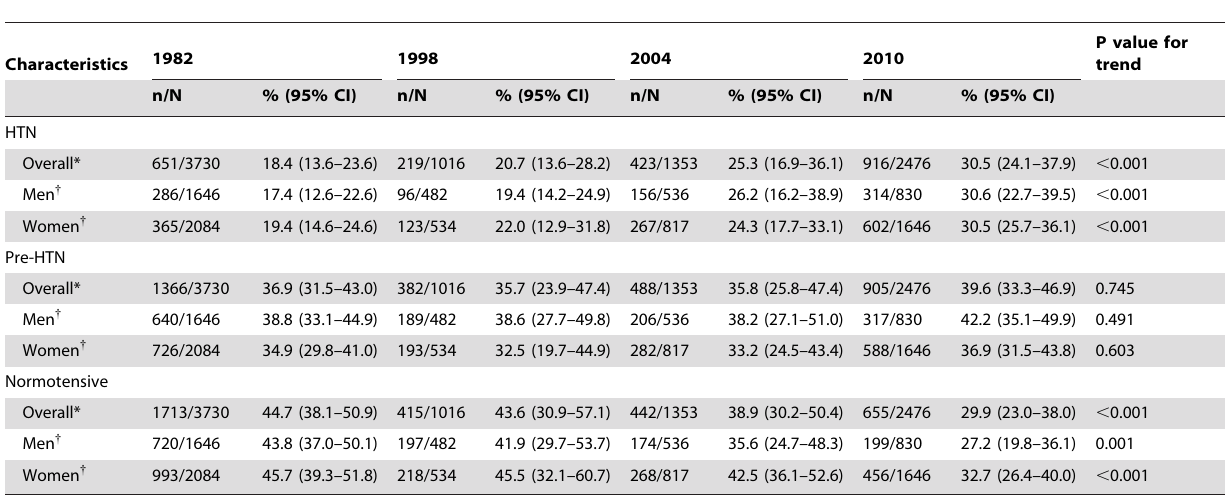
Table 3. Prevalence of HTN, pre-HTN and normotensive for adults aged 35 to 64 years from 1982 to 2010.